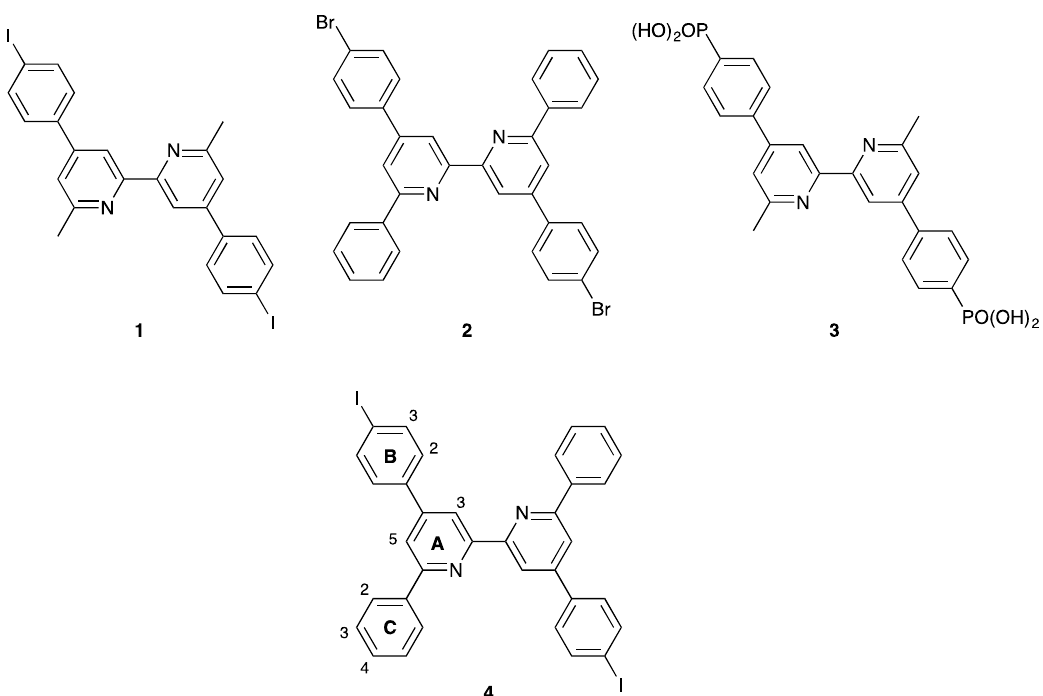
Scheme 2. Structures of ligands and atom labeling for NMR assignments of 4